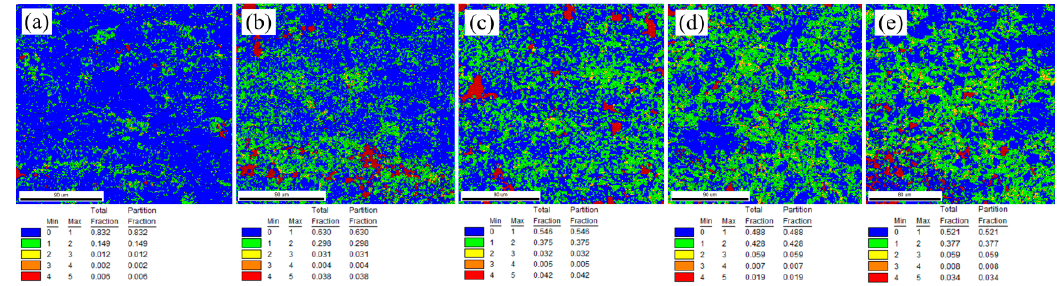
Figure 8. KAM map (in o ) of the fractured AZ31 samples for the different tested configurations: ( a ) undeformed material, ( b ) RT, ( c ) OH, ( d ) AC, and ( e ) EA (red points are artificial points).